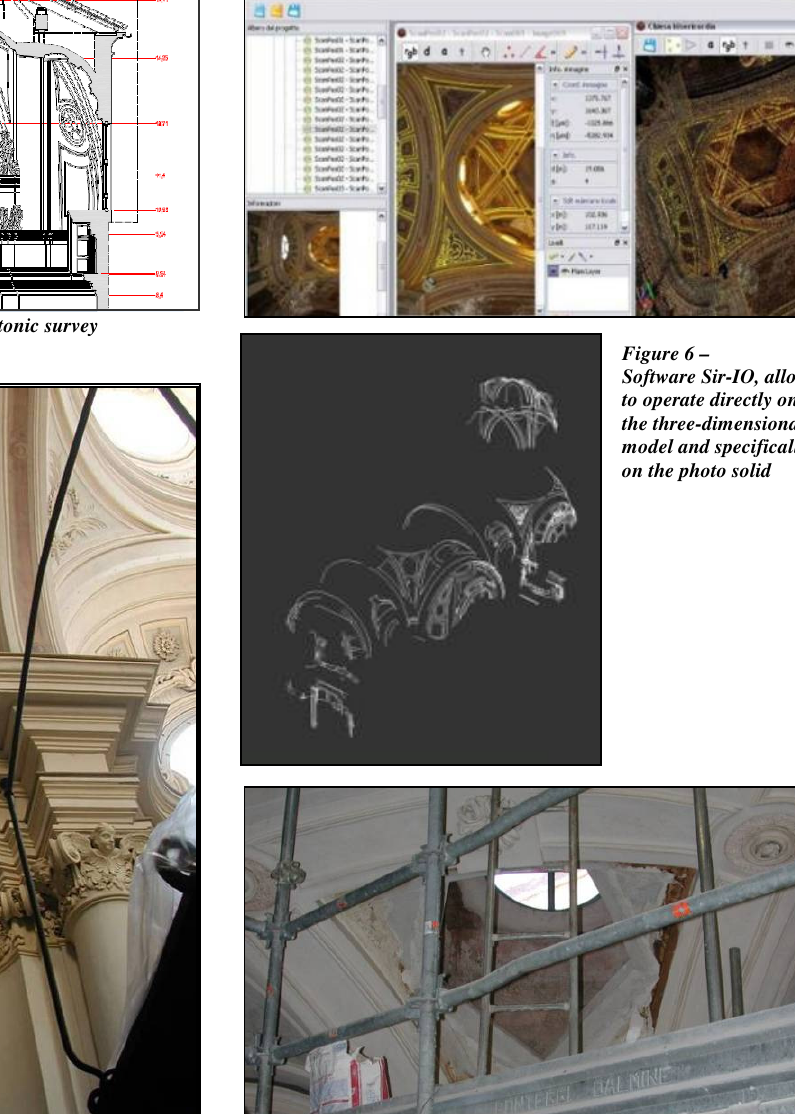
Figure 7 - Opening of the six pentagons located in the dome above the altar after the untap the paint